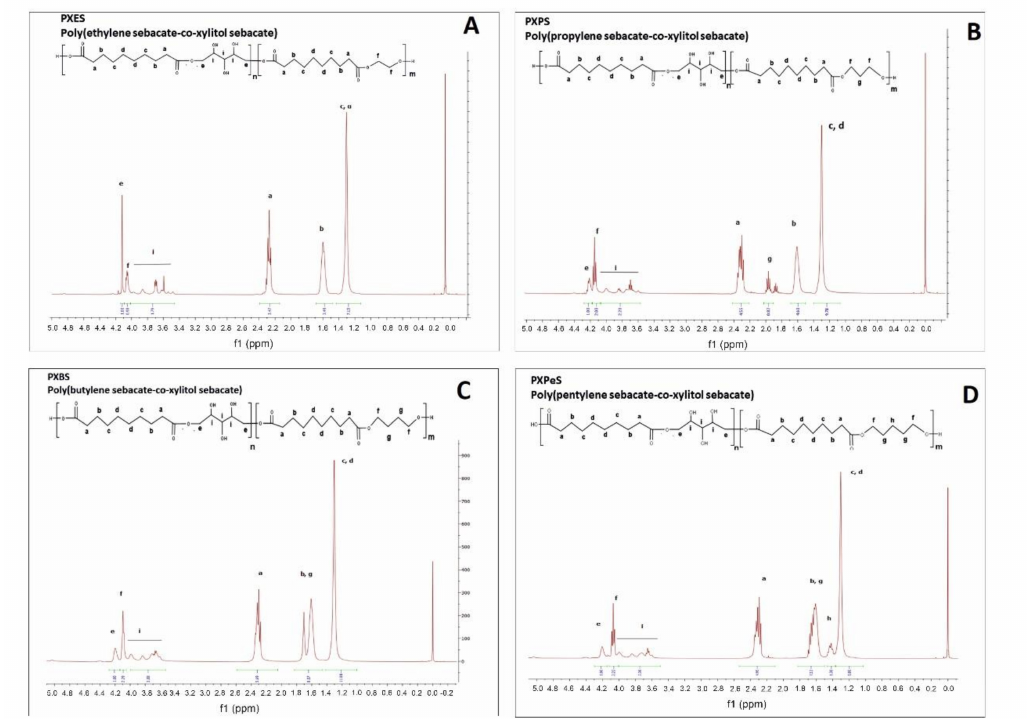
Figure 3. 1H NMR of following prepolymers: PXES ( A ), PXPS ( B ), PXBS ( C ), PXPeS ( D